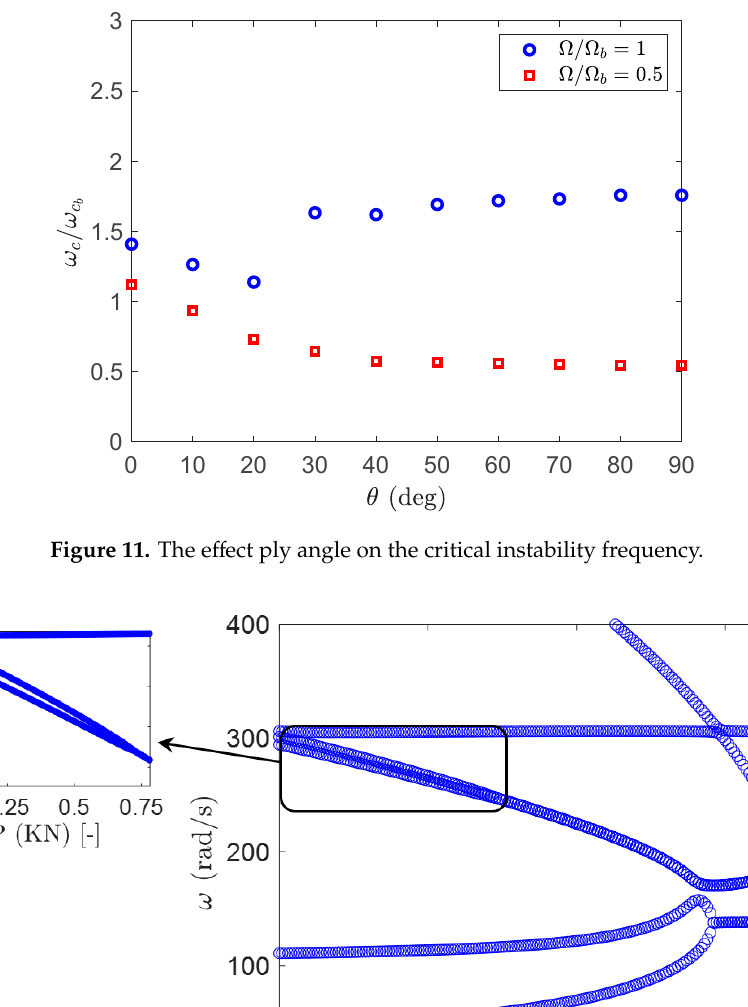
Figure 10. The effect ply angle on the critical instability force.